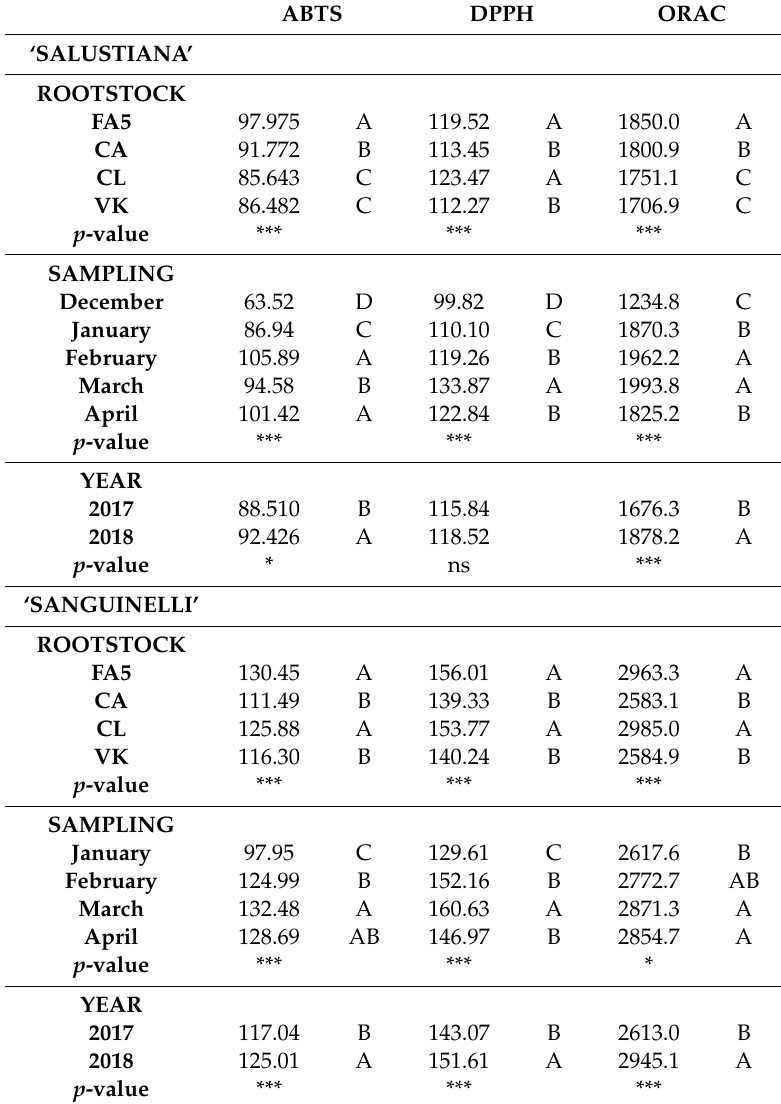
Table 4. E ff ect of rootstock, sampling date, and year on antioxidant activity (ABTS, DPPH, and ORAC) in ‘Salustiana’ and ‘Sanguinelli’ cultivars. ABTS and DPPH are expressed in mg TE / 100 g FW and ORAC in µ M TE / 100 g